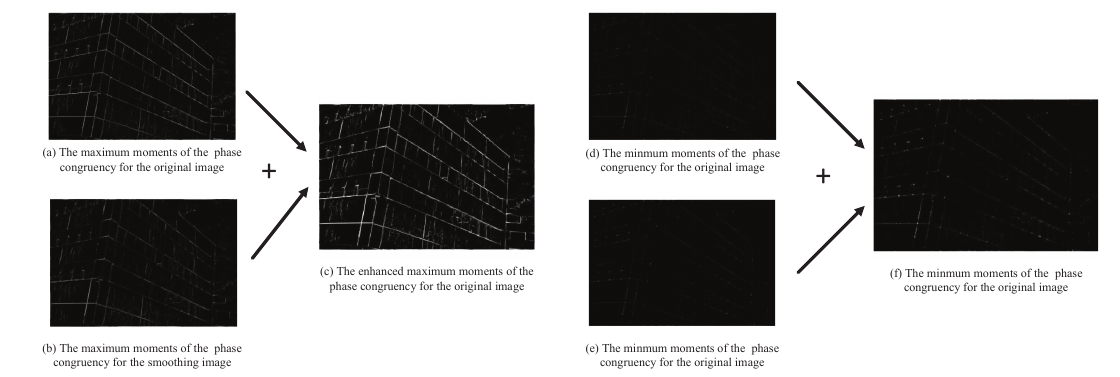
Figure 4. Enhanced moments of the phase congruency